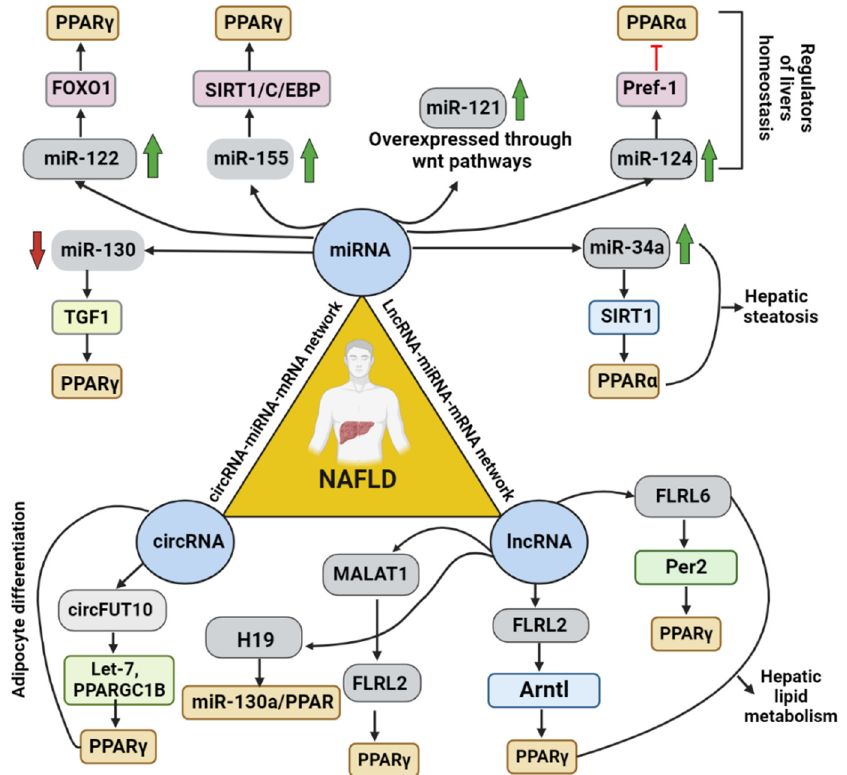
Figure 5. Role of ncRNAs and their respective molecular factors found to be involved in regulating NAFLD progression via targeting PPARs. This figure depicts the suspected pathway and molecules involved in regulating different ncRNA and the type of PPARs involved.